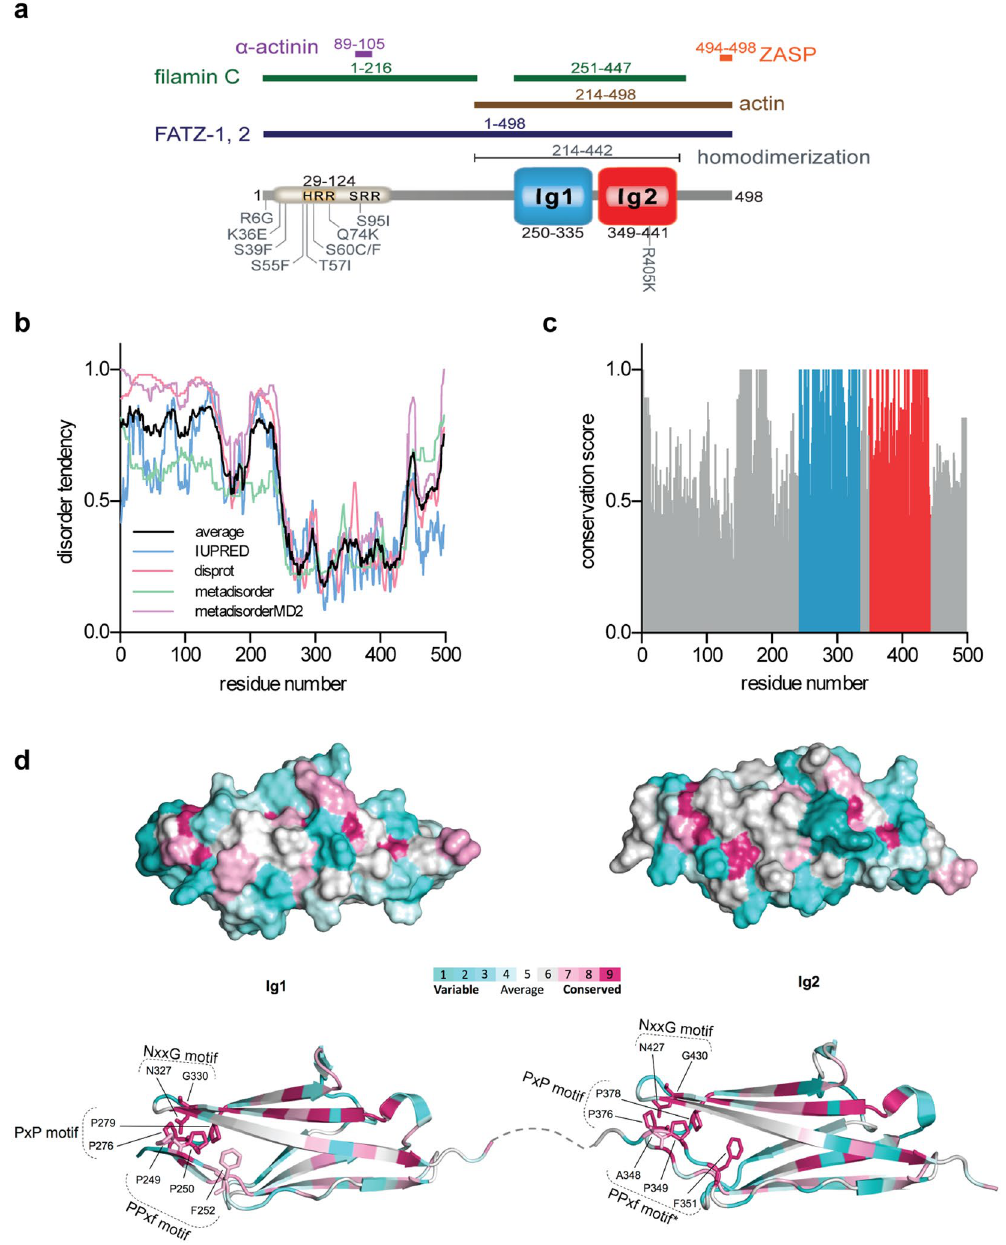
Figure 1. Evolutionary analysis of myotilin. ( a ) Schematic presentation of the myotilin molecule. N-terminal part of myotilin is indicated by the serine-rich region, comprised of »mutational hotspot« and hydrophobic residues stretch (yellow). C-terminal Ig domains 1 and 2 are coloured blue and red, respectively, followed by the C-terminal tail. Binding sites for various binding partners are noted above schematics. ( b ) Disorder tendency plot, calculated with the different prediction software, showing that mainly Ig domains present a structured part of the molecule. ( c ) Conservation plot of every amino acid residue score, calculated from the multiple-sequence alignment. ( d ) Conservation of the Ig domains of myotilin as calculated by the Consurf-DB server. Below are presented conserved residues, forming an N-terminal cluster. The colouring scheme presents purple residues as conserved and turquoise as varied. * PPxf motif on Ig2 domain is APxf, whereas sequences from other organisms possess typical PPxf motif (Supplementary Data